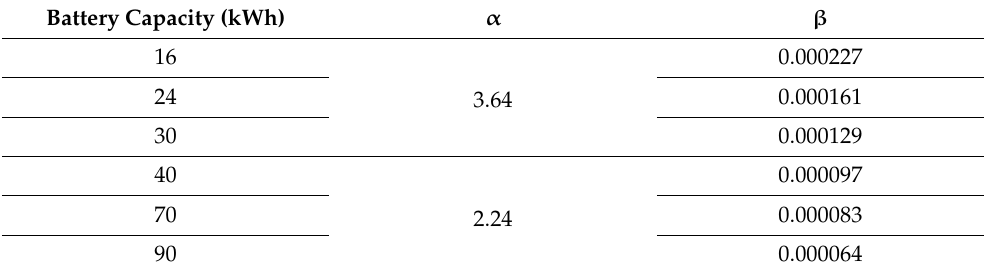
Table 1. D1 degradation model parameters according to battery size.